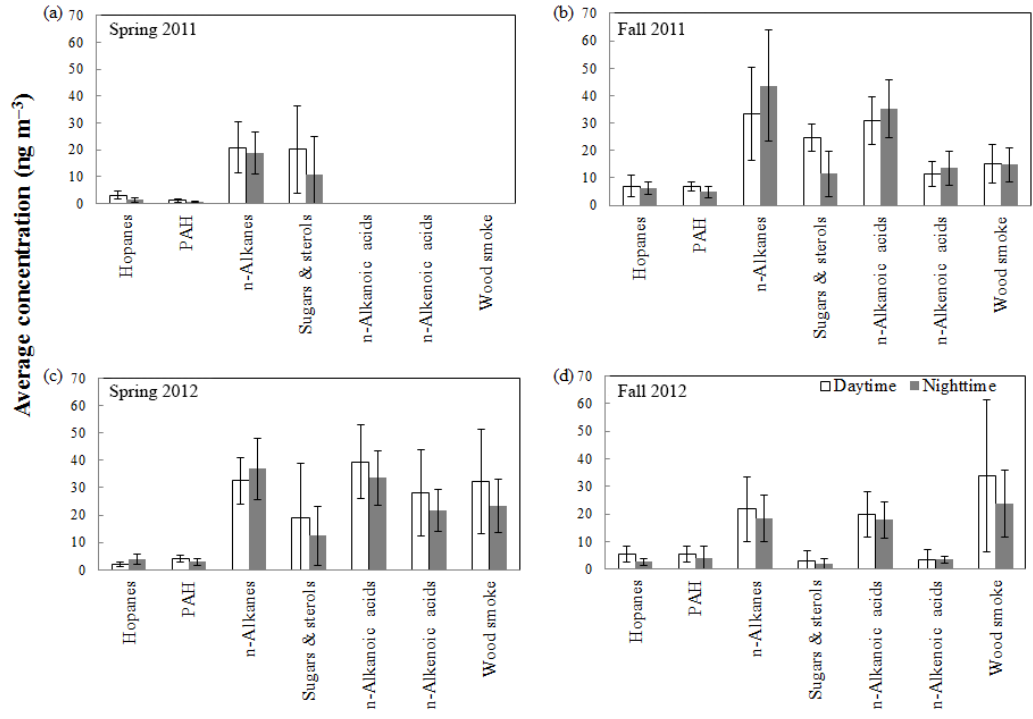
Figure 2. Concentrations of the resolved organic compound classes in the MMA. For (a) the n -alkanoic and alkenoic acids and wood smoke tracer were not included in the chemical analysis. For (b) , (c) and (d) the n -alkanoic acids are divided by a factor of 10.